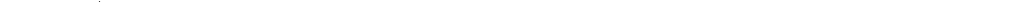
(See figure on next page.) Fig. 4 A 68-year-old man with Middle East respiratory syndrome coronavirus. Serial chest radiographs show a type 4 pattern of progression. A A frontal chest radiograph shows airspace disease involving the in the right upper, mid and lower zone with a chest radiographic score of 12 with bilateral pleural effusion. B On day 4, a follow-up frontal chest radiograph shows further deterioration of right lung air space opacity with increase of bilateral pleural effusion. C On day 6, further worsening of the bilateral air space opacities noted. D A CT scan done on the same day shows bilateral pleural effusion with bilateral air space consolidations. E On day 8, the patient further deteriorated and was put on ventilation. At this stage his serum LDH was 1326 and he died on day